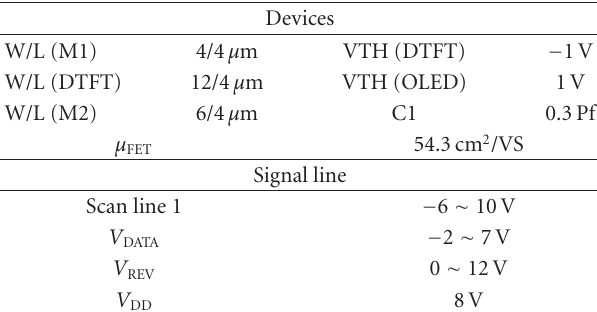
Table 1: Simulation parameters for proposed pixel circuit